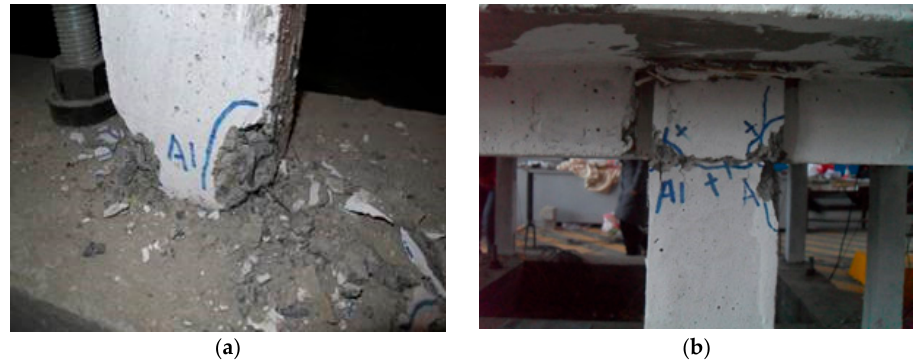
Figure 7. Model damage after Run 6. ( a ) Reinforcement buckling at the column root; ( b ) Concrete spalled at the column end.